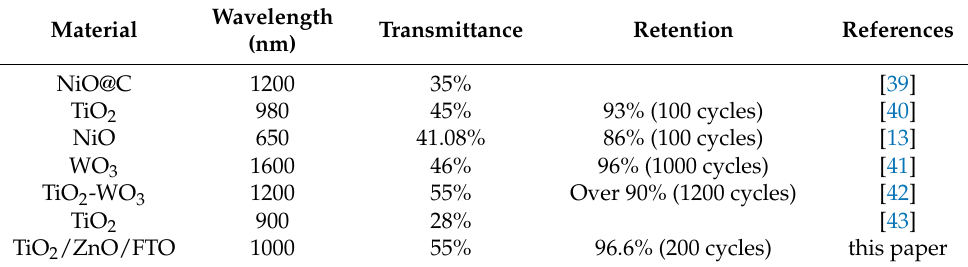
Table 2. Comparison of electrochromic